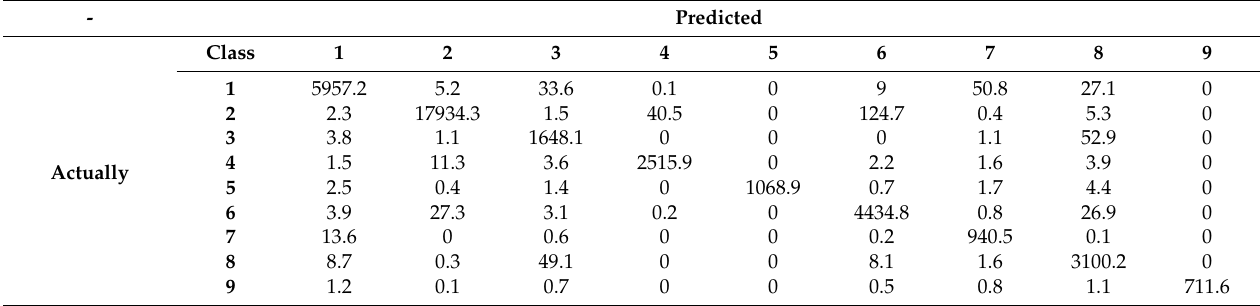
Table A2. The confusion matrix of the proposed ESMLR with linear MFL from the Pavia University dataset corresponding to Table